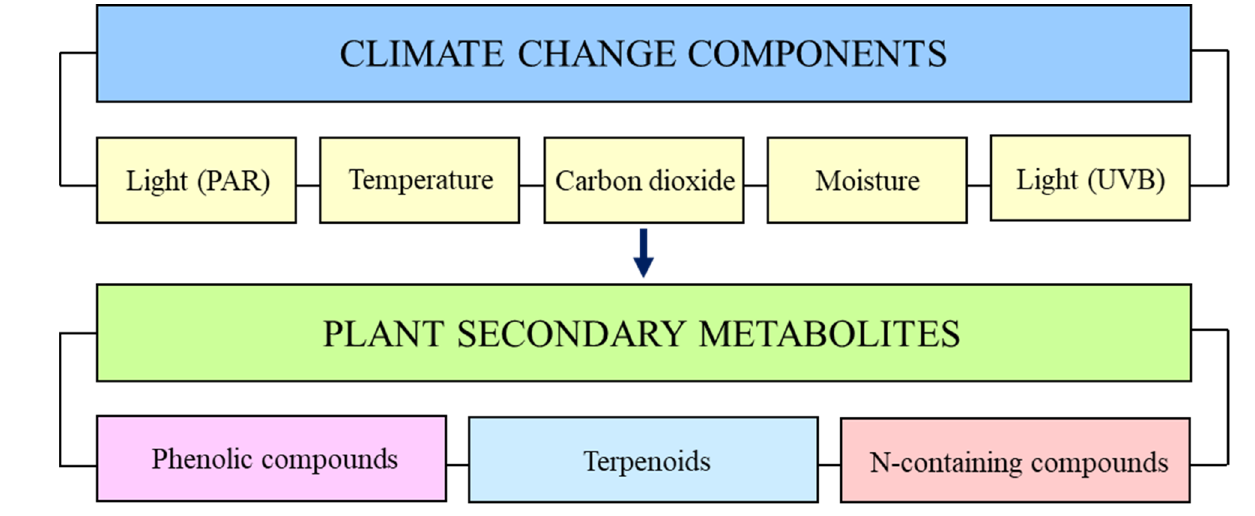
Figure 1. Climate change components that affect plant secondary metabolites.